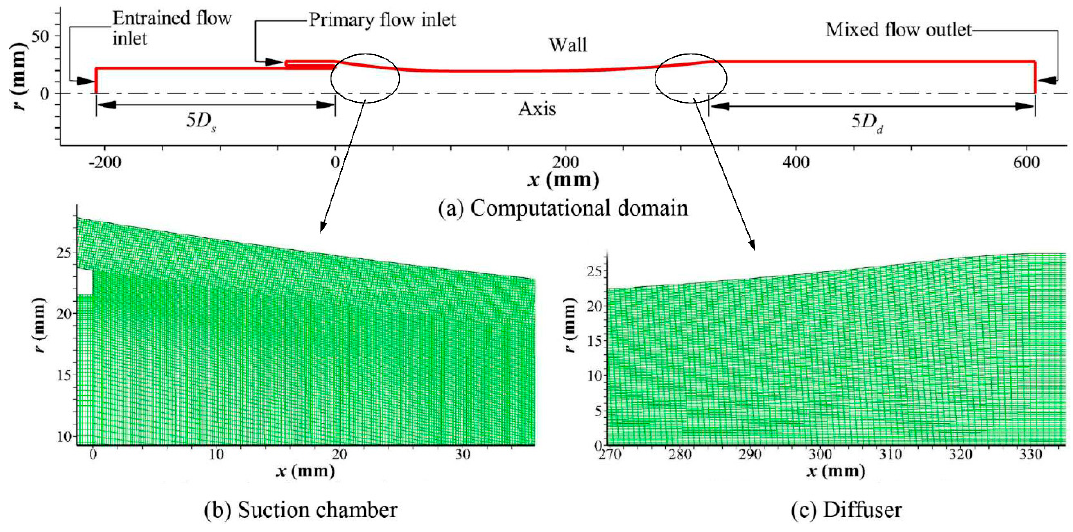
Figure 4. Computational domain and local mesh.